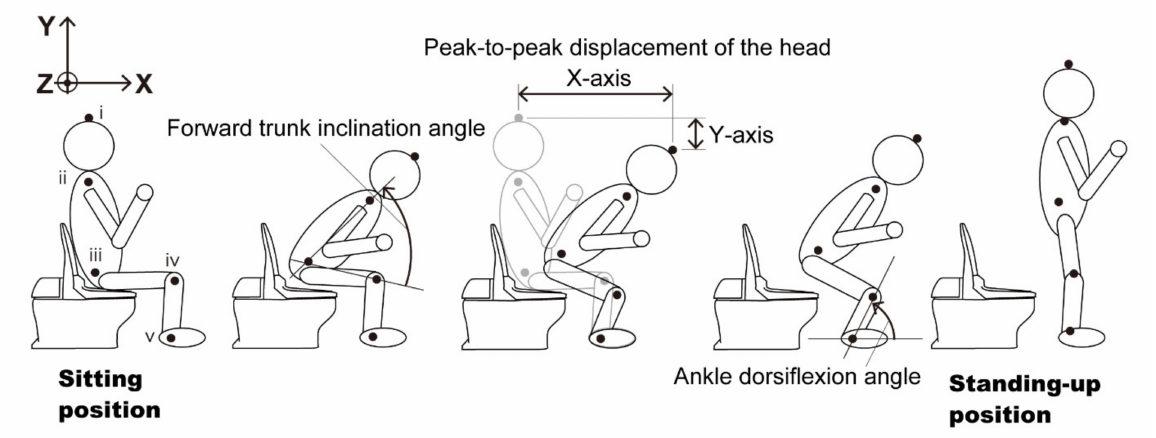
Figure 2. Details of ankle dorsiflexion angle, forward trunk inclination angle, and peak-to-peak displacement of the head ( X and Y -axes) in the sagittal